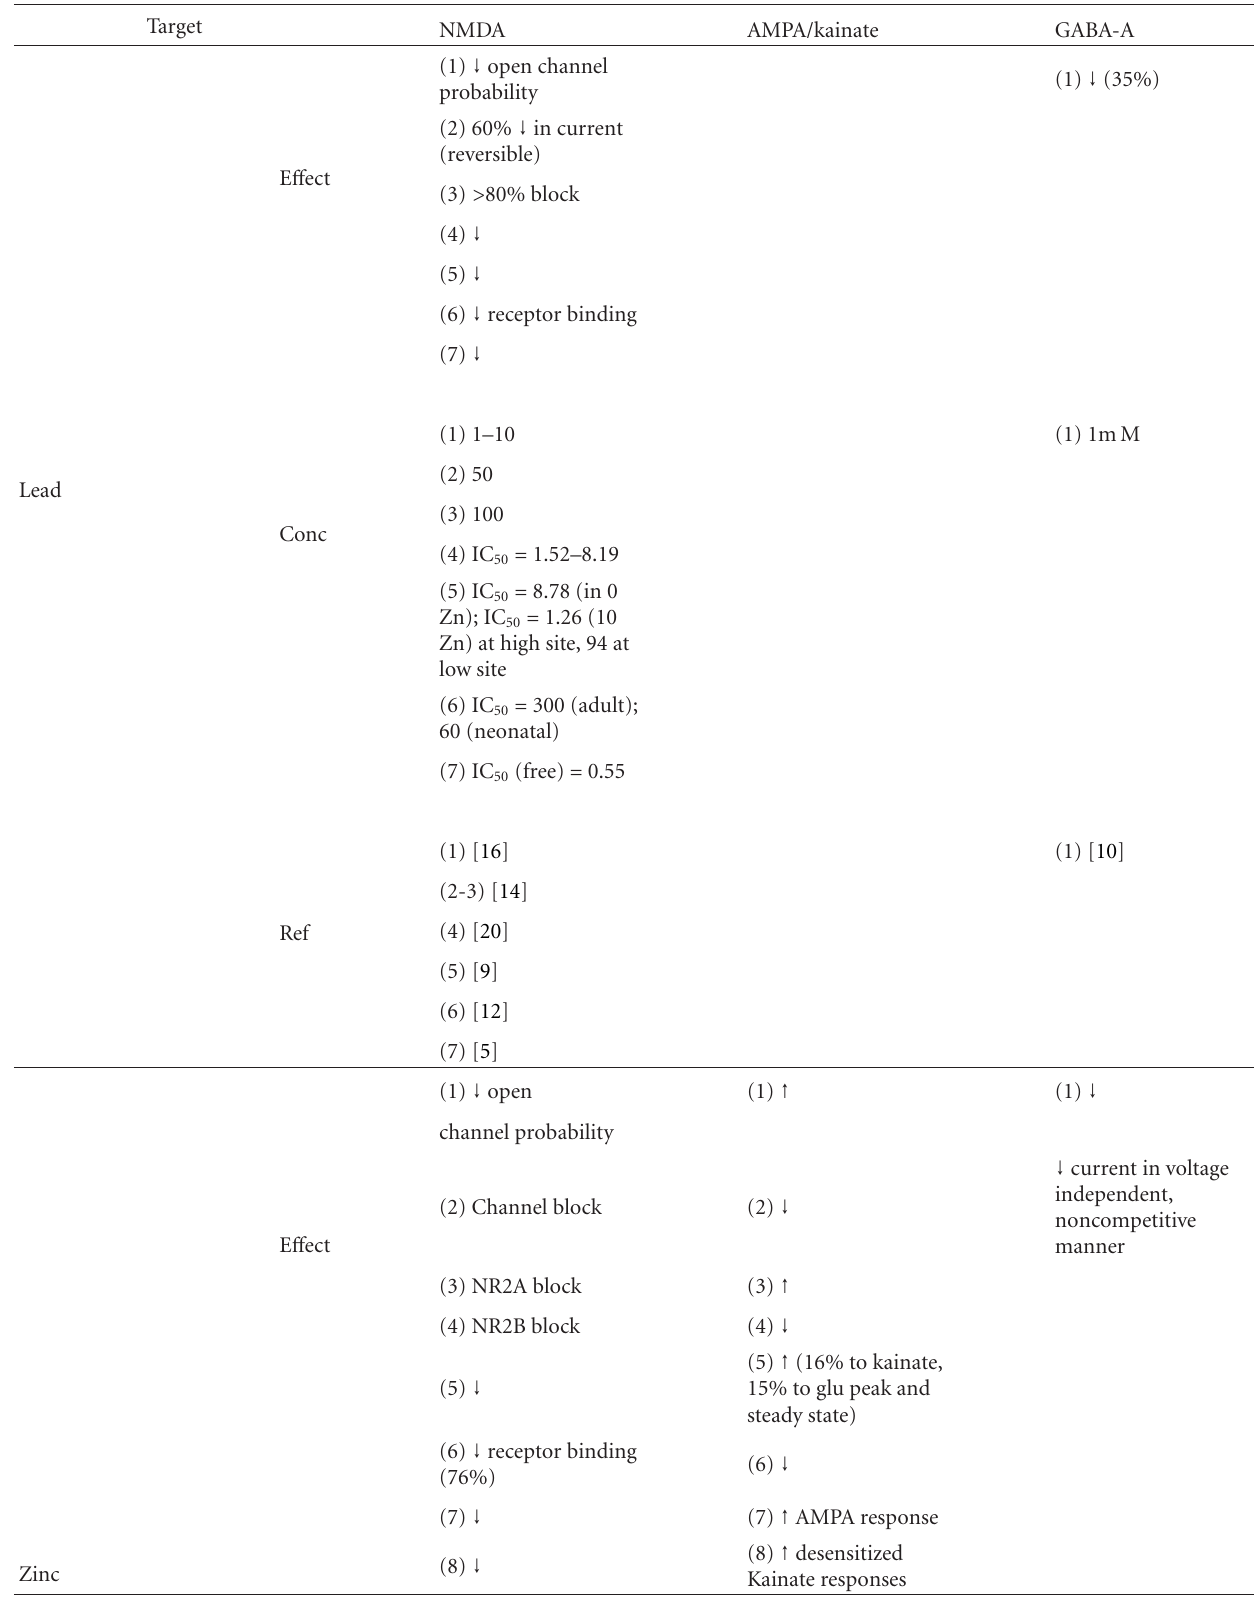
Table 5: E ff ects of metals on postsynaptic ligand-gated ion channels ( ↑ —activation/upregulation, ↓